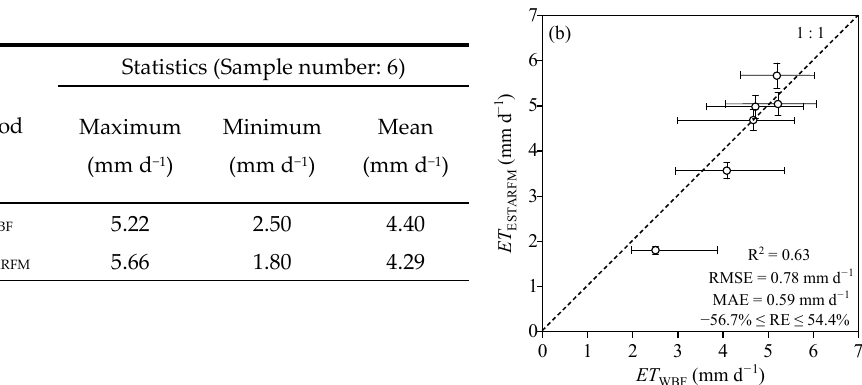
Figure 6. Comparisons of the fused ET ESTARFM by ESTARFM and measured ET WBF in the field experiment for cotton growth under film-mulched drip irrigation in 2019: ( a ) Table for the statistical characteristics of measured ET WBF and fused ET ESTARFM ; and ( b ) 1:1 diagram (R 2 : coefficient of determination; RMSE: root-mean-square error; RE: relative error; MAE: mean absolute error).